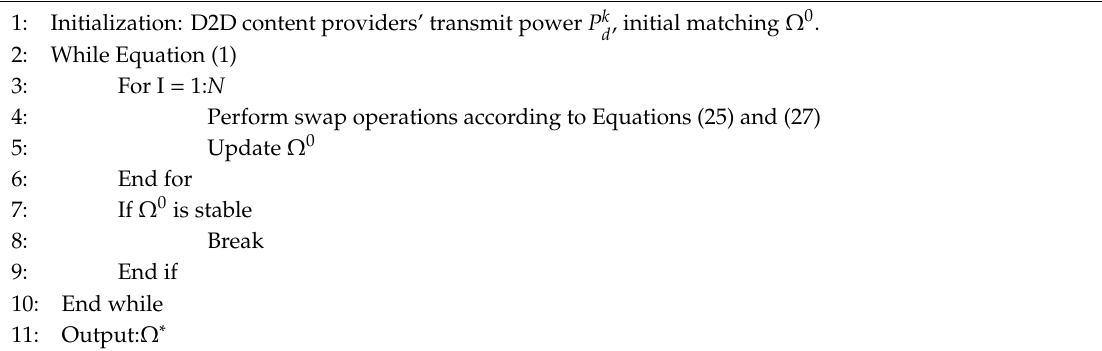
Algorithm 2 Channel allocation based on many-to-one matching